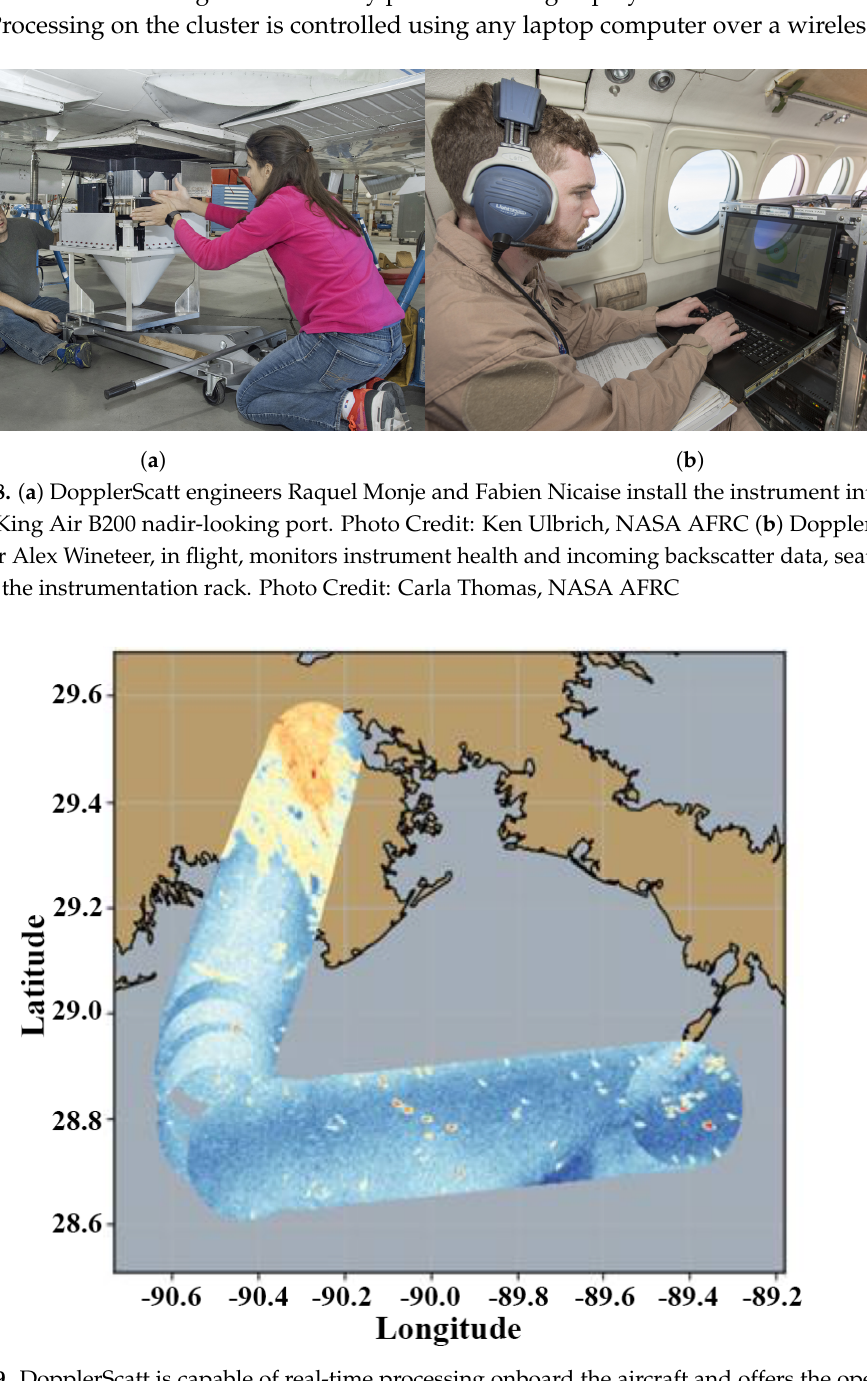
Figure 9. DopplerScatt is capable of real-time processing onboard the aircraft and offers the operator a view of radar return power during the flight. This view was taken during a flight line in the Gulf of Mexico in April 2017. The boundary between land and ocean is clearly visible, as are the many highly reflective oil platforms in the region. Winds were blowing towards the North-West in this data. Note that striped artifacts appear as a result of the timing of arrival of data packets due to parallel